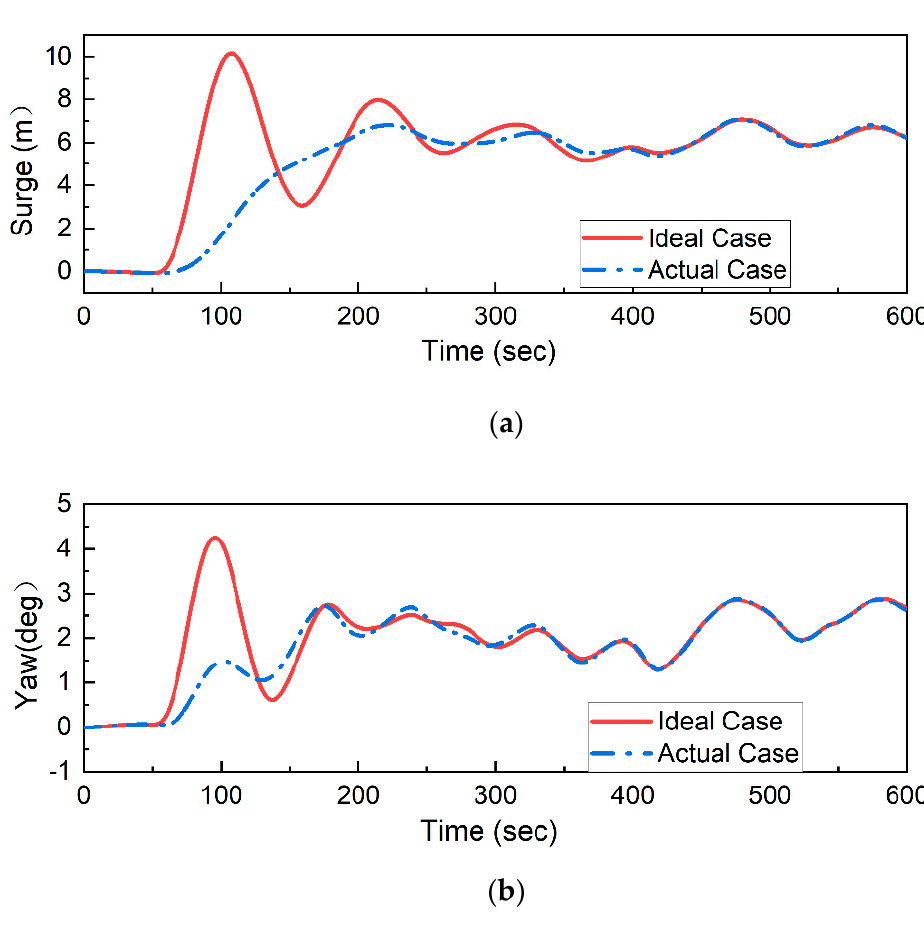
Figure 10. Buoy motion via different controlling strategies. ( a ) Surge; ( b ) Yaw.